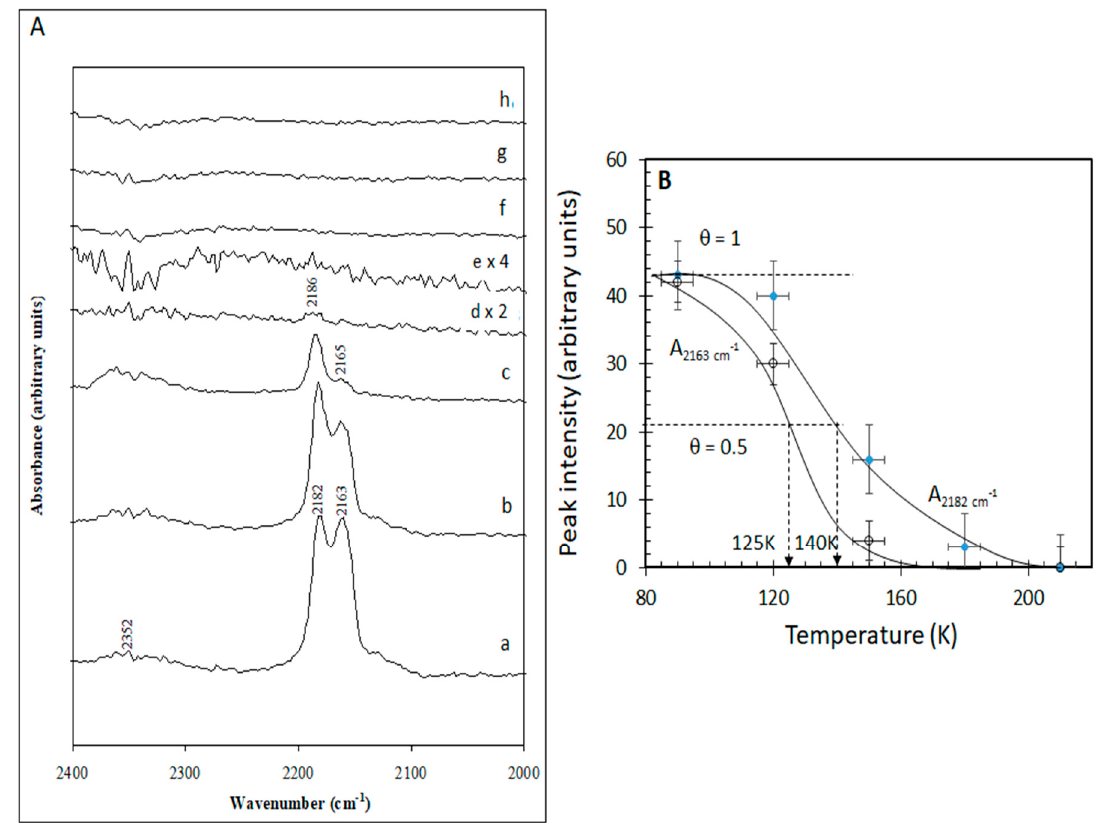
Figure 4. ( A ) FT-IR spectra of CO adsorbed on CeO 2 at (a) 90 K, (b) 120 K, (c) 150 K, (d) 180 K, (e) 210 K, (f) 240 K, (g) 270 K, and (h) 290 K. ( B ) Change of coverage with temperature, the surface coverage, ν , at 90 K was taken as 1.